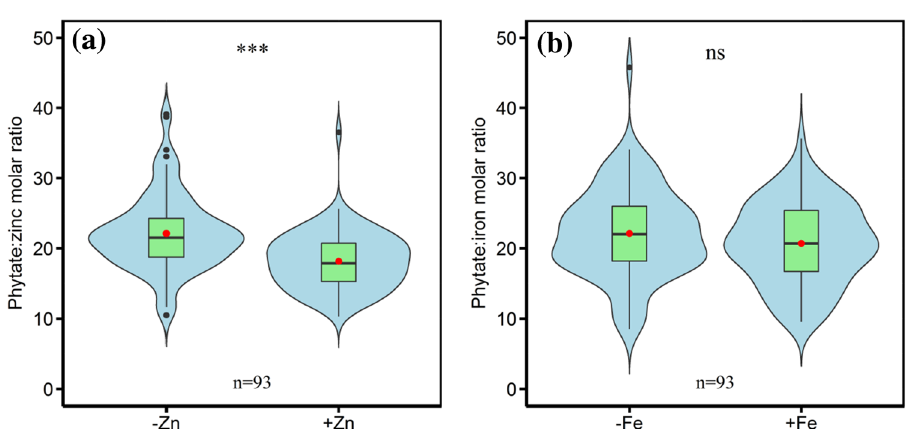
Figure 7. Effects of foliar application of micronutrients on the molar ratios of ( a ) phytate:zinc and ( b ) phytate:iron in grains of the ninety-three wheat accessions. Note: The boxes boundaries indicate the 75% and 25% quartiles; whiskers indicate the 95% confidence limits; the black circles indicate outliers; the solid horizontal line and red circle indicate median and mean, respectively. * ** is statistically significant at P < 0.001, ns indicate not significant at P <